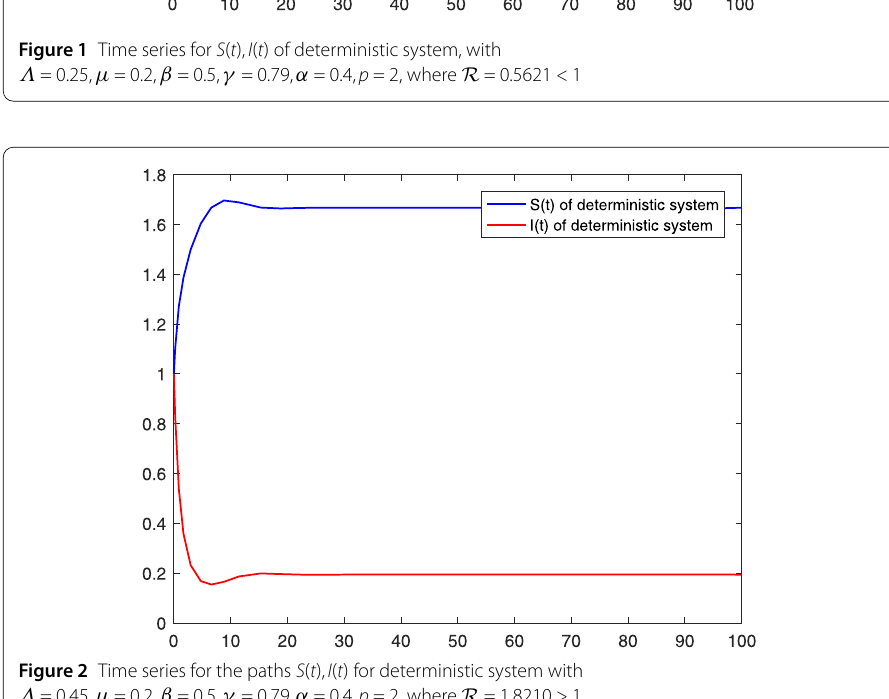
Figure 2 Time series for the paths S ( t ), I ( t ) for deterministic system with Λ = 0.45, μ = 0.2, β = 0.5, γ = 0.79, α = 0.4, p = 2, where R = 1.8210 >